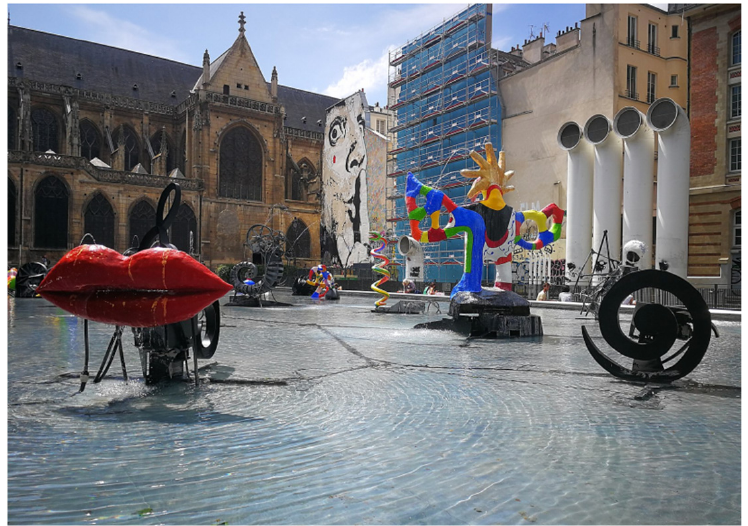
Figure 4. LaFontaine Stravinsky reprinted with permission from [67]. Copyright 1983. Niki de saint Phalle and Jean Tinguely.